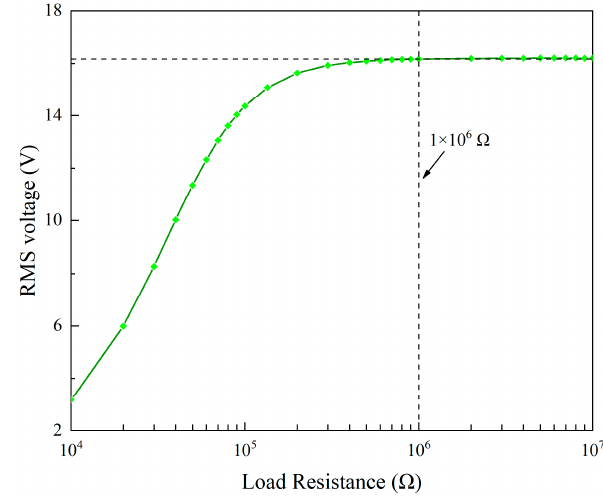
Figure 14. RMS voltage varies with the load resistance.